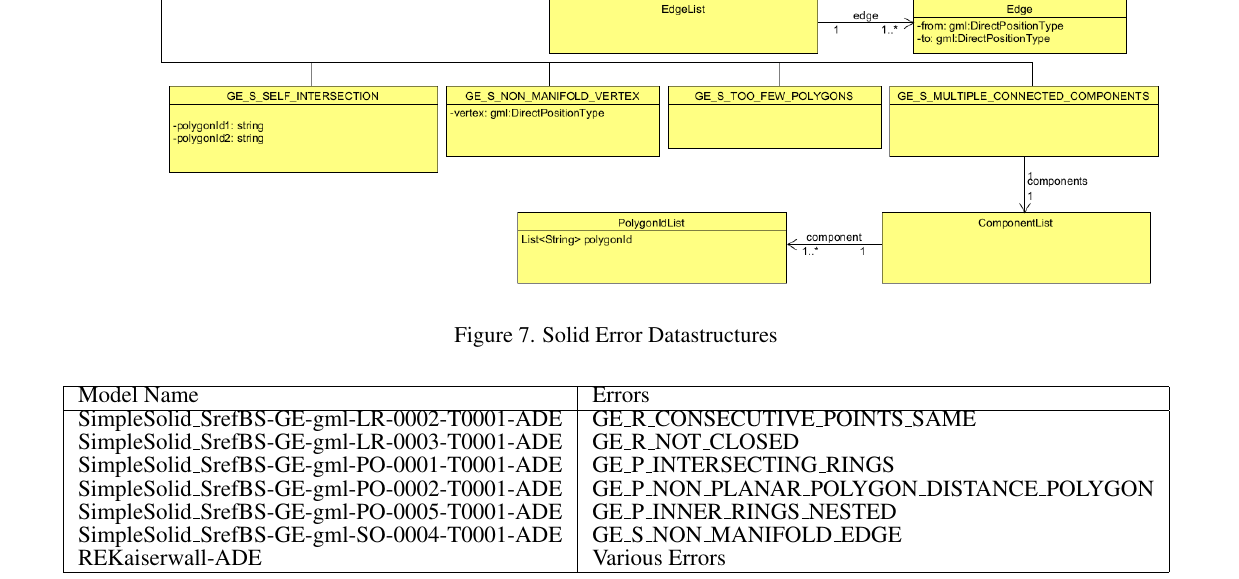
Table 4. Model examples with ADE information stored